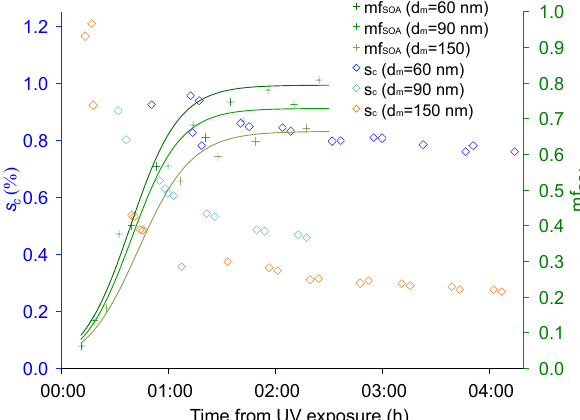
Figure 7. Decreasing critical supersaturation ( s c , blue) and increas- ing mf SOA (green markers, empirical; green line, fit) for three dif- ferent mobility diameters ( d m = 60, 90, and 150nm) from measure- ments of flame soot generator particles over time, during experiment